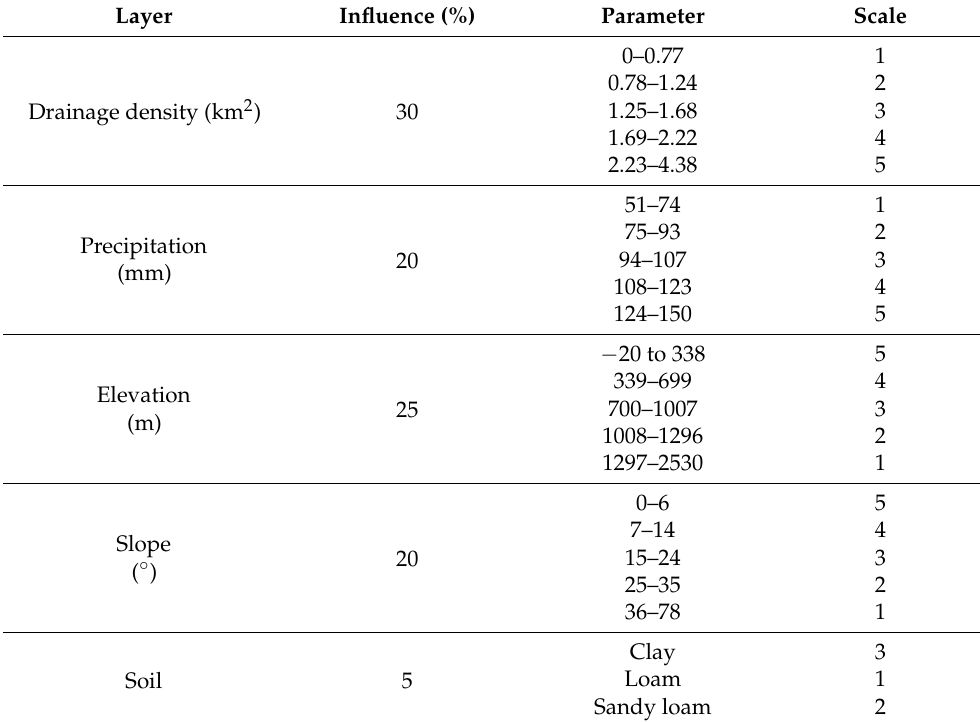
Figure 10. Map displaying the potential groundwater zones in the Neom area. Approximately 515 km 2 of land has good groundwater potential. Table 2. Showing the five layers used to identify the potential flood zones and their influences, classes, and scales. Layer Influence (%) Parameter